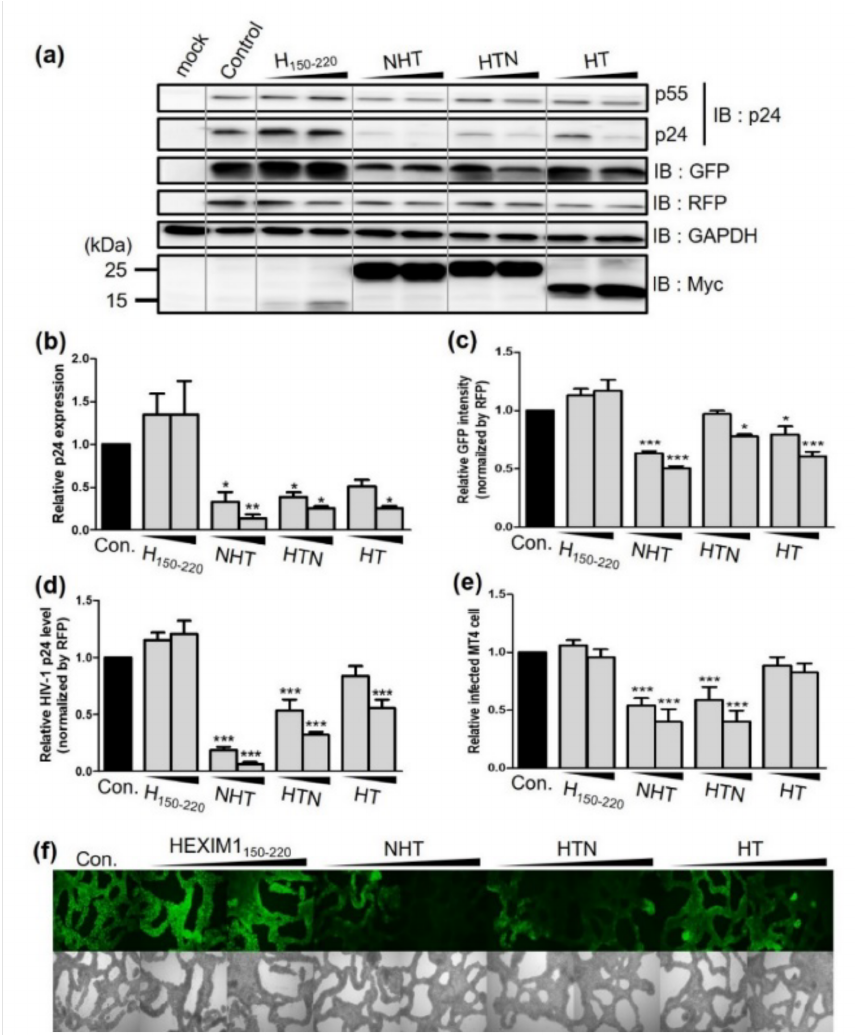
Figure 2. Effect of HEXIM1 derived chimeric proteins on the virus production in HEK293T cells. ( a ) Western blotting results using cell lysates. Upper panel: expression of viral proteins, RFP trans- fection control and GAPDH as the housekeeping gene. Bottom panel: expression of H 150-220 and its derivates. ( b ) Intensity of the p24 band in western blotting ( n = 3). ( c ) Intensity of the GFP signal derived from the proviral vector in the cell lysate ( n = 5). ( d ) Supernatant viral titer quantified by p24 ELISA and normalized by the RFP level ( n = 5). ( e , f ) Viral supernatant harvested from transfected HEK293T cells was used to transduce 1.4 × 10 5 MT4 cells. MT4 cells were infected with the same volume of viral supernatant. Detection of GFP-positive infected cells by FACS ( e ) and fluorescence microscopy ( f ). All the microscopy images were at 100 × magnification. Statistical significance was assessed using one-way analysis of variance (ANOVA; * p < 0.05, ** p < 0.01, *** p < 0.005). RFP, red fluorescent protein; GFP, green fluorescent protein; GAPDH, glyceraldehyde-3-phosphate dehydrogenase; ELISA, enzyme-linked immunosorbent assay; FACS, fluorescence-activated cell